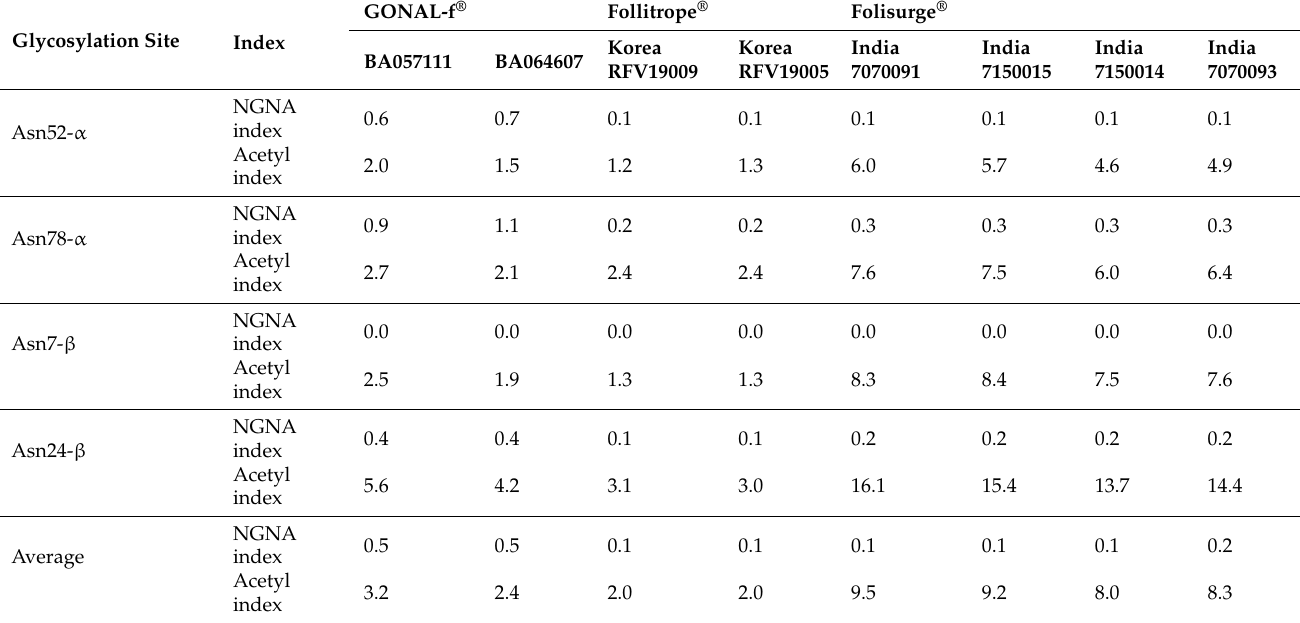
Table 3. Degree of NGNA and O -acetylation for GONAL-f ® , Follitrope ® and Folisurge ® .